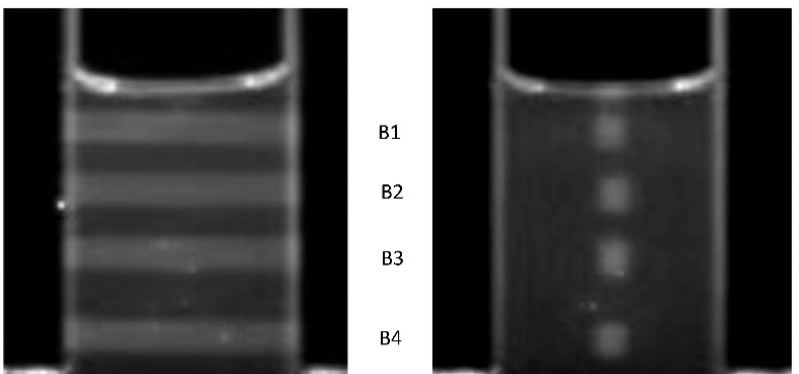
Figure 15. Images taken with Fluorotome 1 of a 20 × 20 mm square, ±30 mm long RFG gel that has been irradiated with four 3 mm square 300 kVp x-ray beams, denoted B1-B4 in the figure. All have total entrance doses of 15.9 ± 0.3 Gy with dose rates from 3.9 to 1.3 Gy/min (top to bottom). The plane of the UV-sheet was at the center of the cell (depth 10 mm) and parallel (left) or orthogonal (right) to the x-ray penetration direction. Linear pixel profile scans, P B versus distance, across the irradiated areas in Figure 15 (right) are shown in Figure 16, with and without background subtraction.